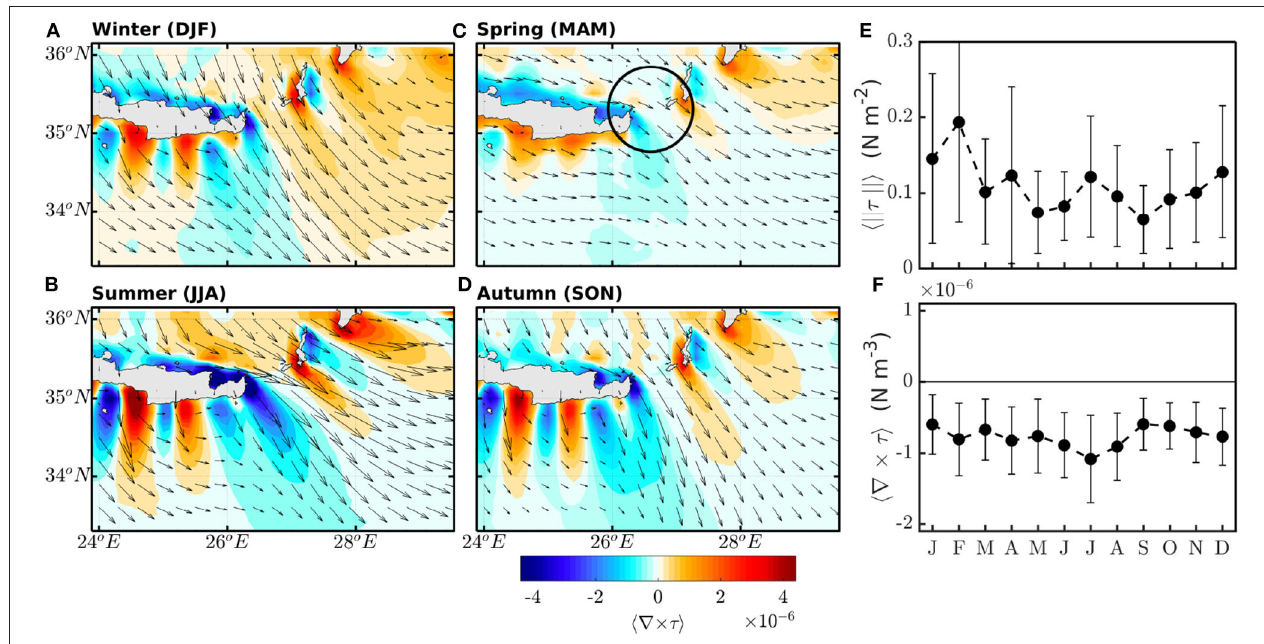
FIGURE 3 | Climatological wind stress h τ i (vectors) and wind stress curl h∇ × τ i (colors) during 2015 for the winter (A) , spring (B) , summer (C) , and autumn (D) months based on ARPEGE wind data. The selected area for analyzing the wind forcing climatology is illustrated with the black circle in (B) . The mean monthly climatological variations of wind stress h τ i and wind stress curl h∇ × τ i are shown in (E,F) ,